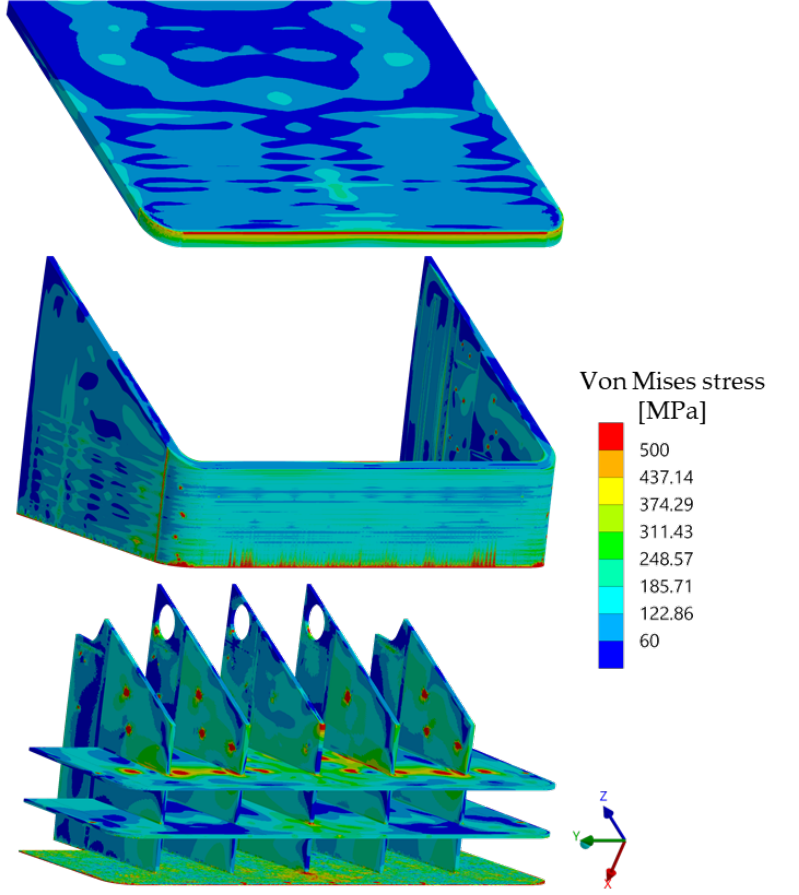
Figure 22. Von Mises stress field within Eurofer domain.